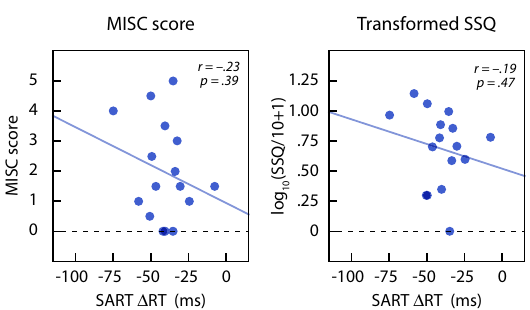
Fig. 6 Cybersickness experienced by individual subjects during virtual navigation in Experiment 1 plotted as a function of their attentional allocation scores derived from SART (ΔRT Positive values of ΔRT correspond to more attention to the periphery. Lines show the regression fits. The left graph plots the MISC scores and the right graph plots the SSQ scores after transforming by log 10 (SSQ/10 1) +